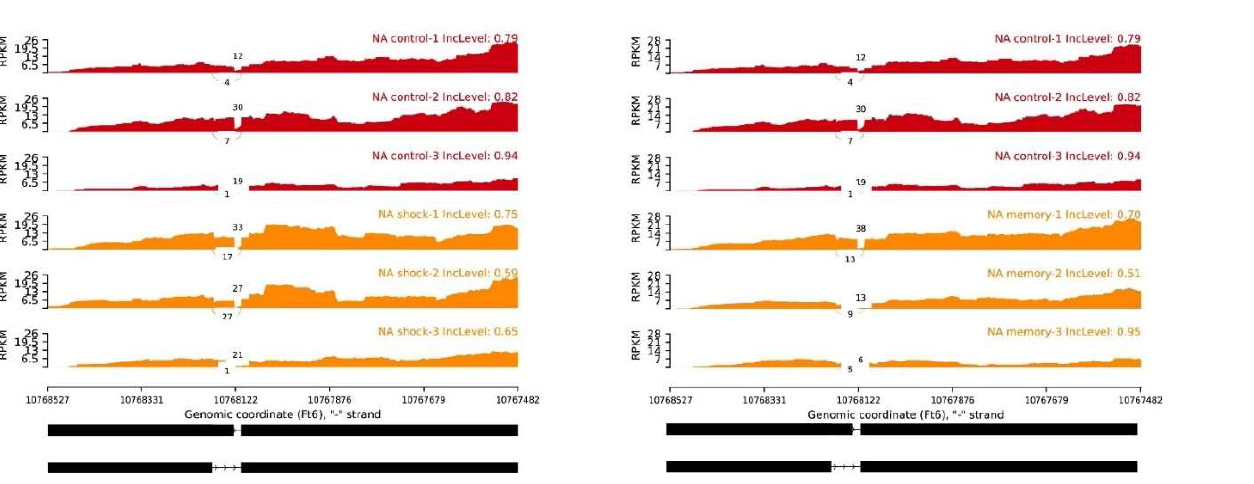
Figure 6. Alternative splicing of FtHDA8-2 is associated with different low-temperature treatments. Sashimi plot indicating the average RNA-seq read density and splice junction counts for each genotype. ( A ) C group vs. S group. ( B ) C group vs. M group. C: living at room temperature always; S: